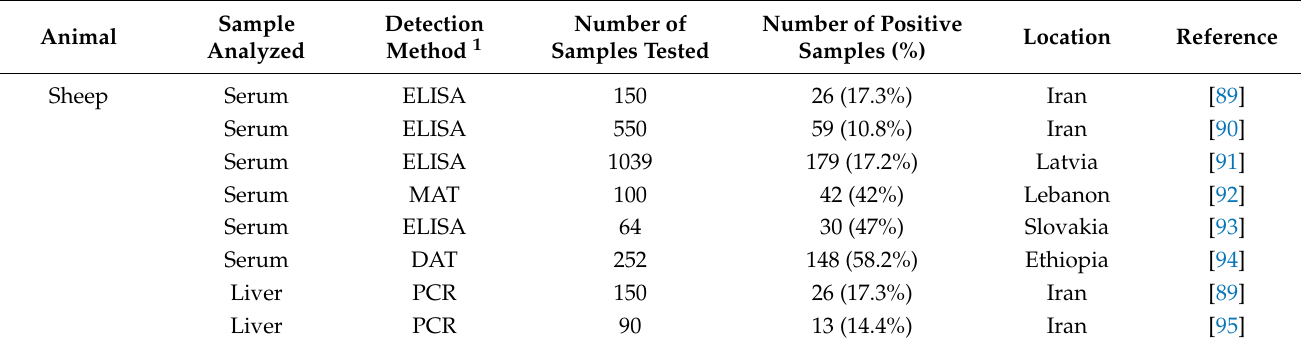
Table 2. T. gondii in animals and animal products. The table shows the producer animal, sample contaminated, country of contamination, method that was used for detection, and prevalence that was